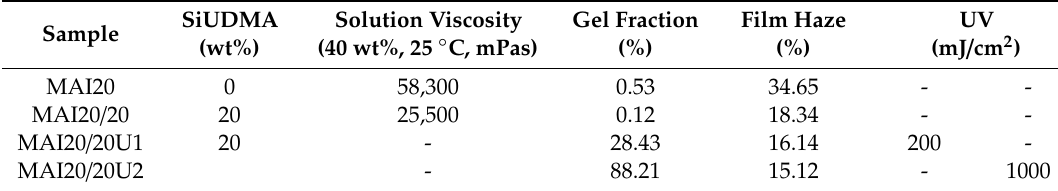
Table 4. Detailed information on SiUDMA-modified MAI20.